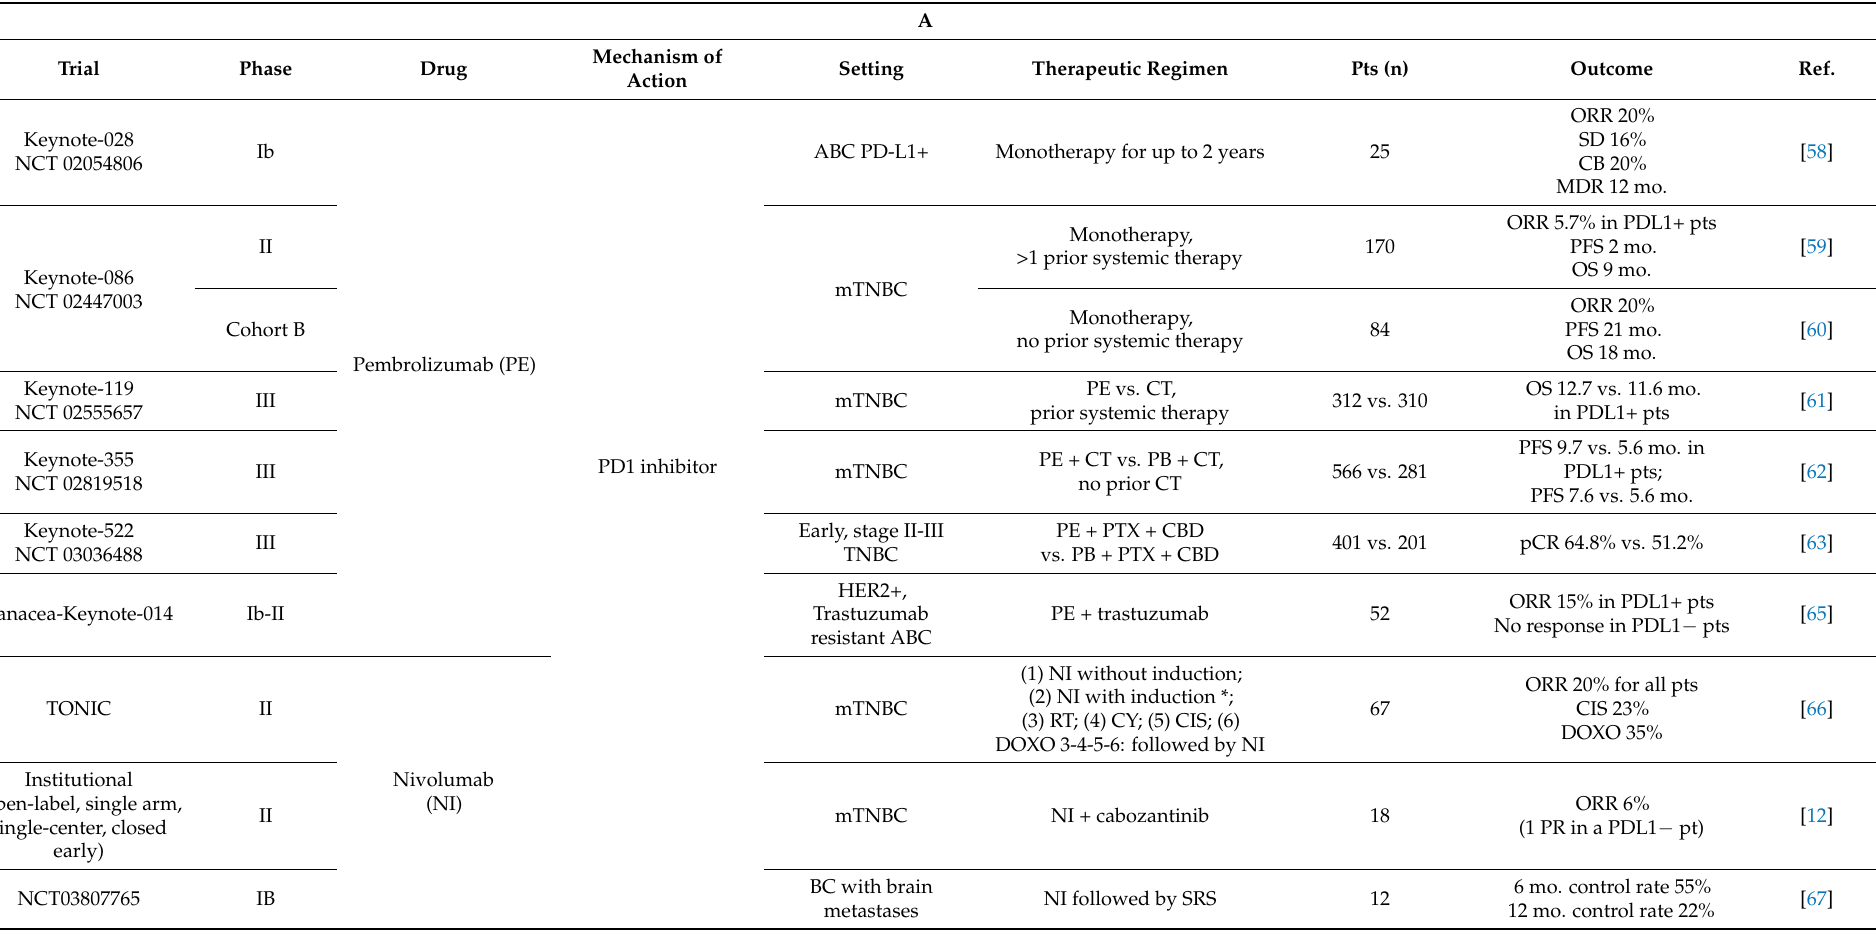
Table 2. Main clinical trials conducted with immune checkpoint inhibitors (ICIs) in breast cancer. ( A ) Clinical trials with pembrolizumab (PE) or nivolumab (NI). ( B